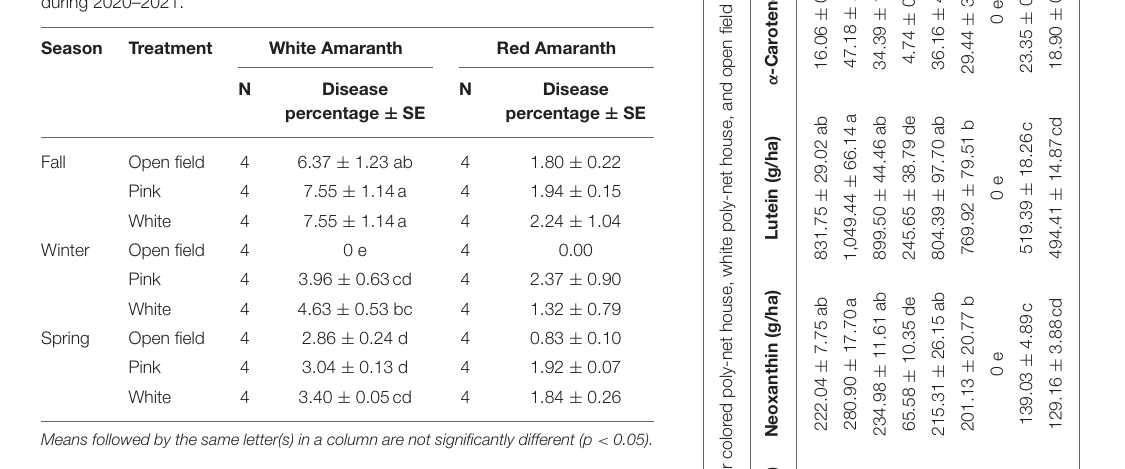
TABLE 5 | Disease incidence (%) on white amaranth and red amaranth under colored poly-net house, white poly-net house, and open field conditions in Taiwan during